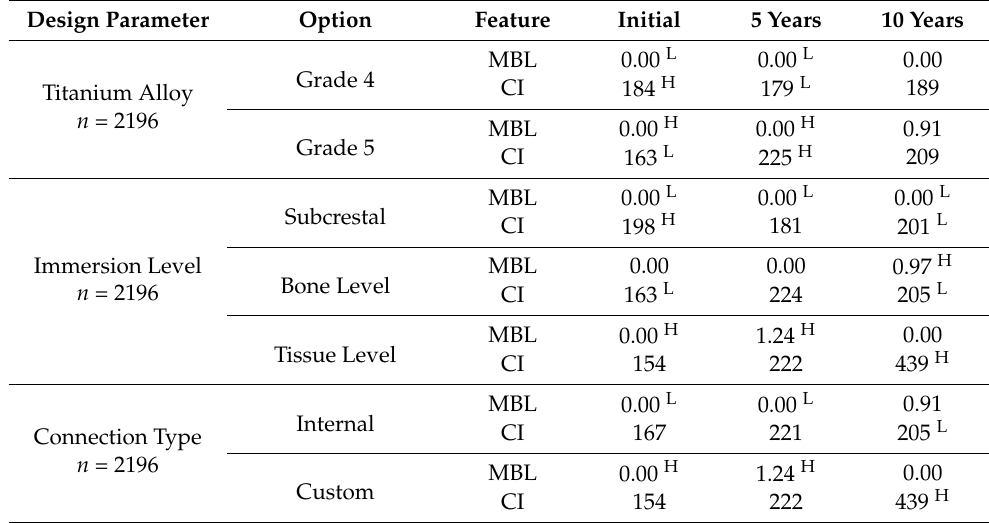
Figure 5. The results obtained for the types of dental implants studied. The charts on the left show the results of the corticalization evaluation (five and ten years). The results here are arranged from lowest mean ( top ) to highest mean ( bottom ). On the right are the results of marginal bone loss arranged in the same order as for corticalization—it can be seen that bone loss does not absolutely correspond to corticalization. Table 4. Peri-implant bone feature observed among examined implant designs groups.